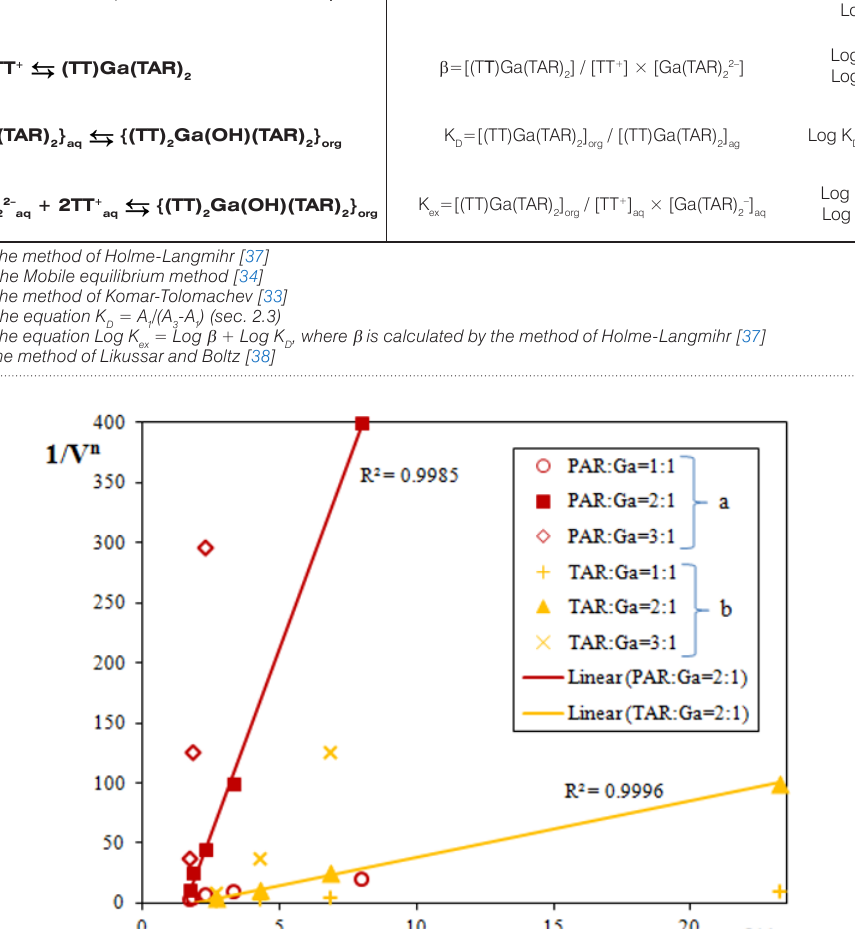
=7.20×10 −6 mol L -1 and C =3.0×10 -4 mol L -1 Ga(III) TTC